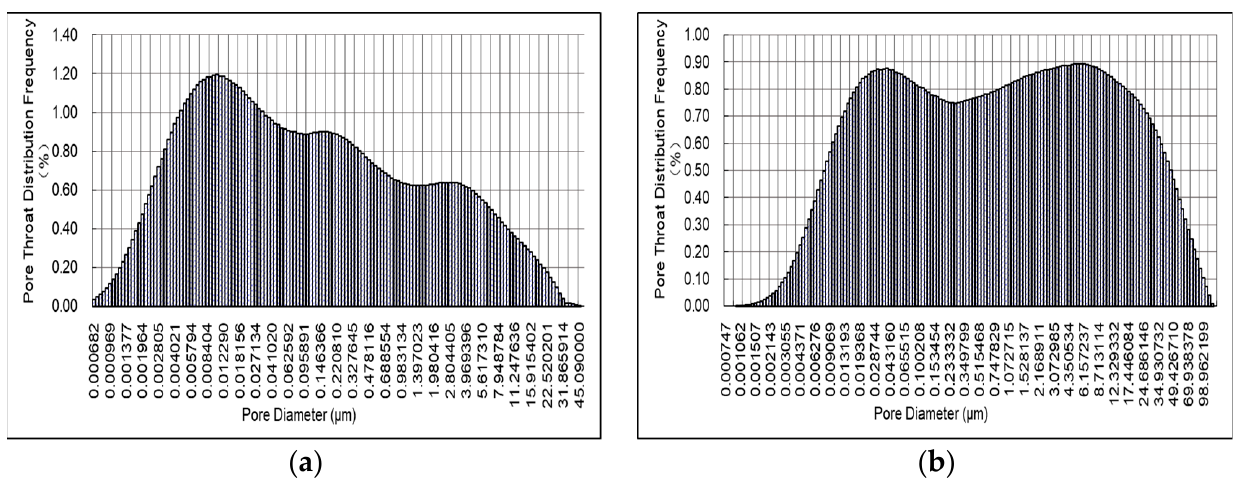
Figure 7. Distribution of core pore size (No. 51 of Well XX2-1-5): ( a ) before fracture; ( b ) after fracture. According to the basic shape of the pore size distribution before and after fracture, it is found that the pore size distribution of the core before fracture is mainly unimodal and bimodal, and the main peak is concentrated on the left side, while the side peaks are not obvious. This feature indicates that the overall pore size before fracture is very small, with more than half of the pore size less than 20 nm, which makes the pore type complex, resulting in poor connectivity between large and small pores and high capillary resistance. Therefore, during the displacement process, it mainly shows the fluid output in the large pore space and the difficulty of fluid flow in the small pore space, resulting in poor gas-driving effect and serious water-blocking phenomenon. After a fracture, it is observed that both the primary and secondary peaks showed a tendency to move to the right, and the secondary peaks became larger. It means that the proportions of the large pore size become larger after fracture, and the proportions of small pore size become smaller, while the ratio of pore sizes less than 20 nm is only about one-third. The pore size distribution becomes wider, and the connectivity between large and small pores is well improved, which weakens the nonhomogeneity of the reservoir. During the displacement process, as the capillary resistance of the fluid decreases, more water in the pore space is displaced by the gas, and the residual water saturation decreases, which ultimately improves the water-blocking phenomenon